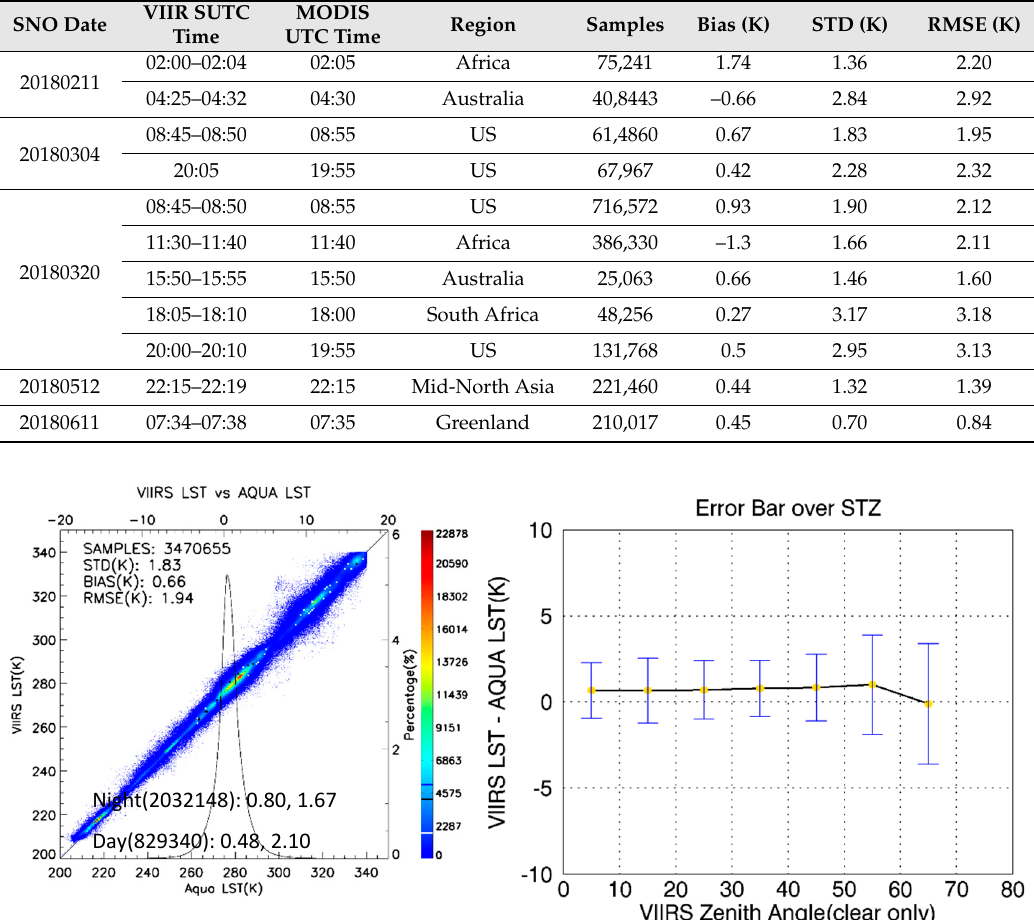
Figure 8. N20 LSTs compared with AQUA MODIS (left), error budget over satellite zenith angles of N20 (right). Colors denote the matchup density.